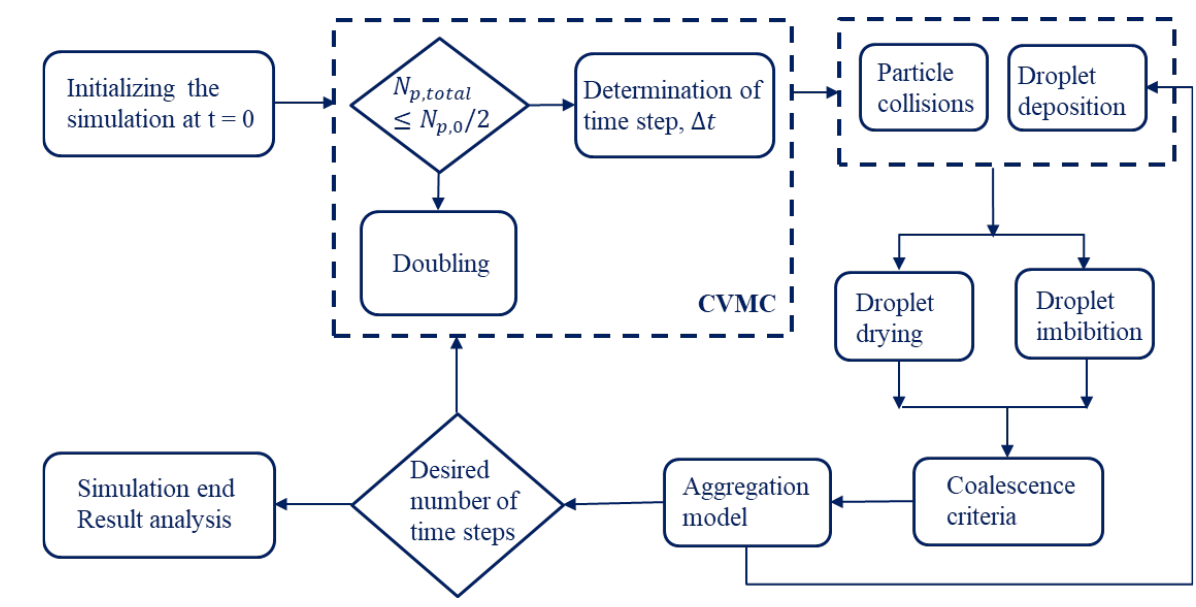
Figure 1. Flowchart representation of the MC modeling for SFB agglomeration of milk powder.